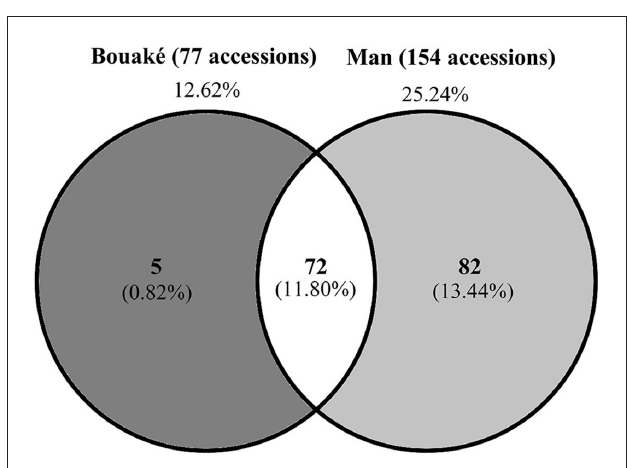
FIGURE3 Proportion of Cassava mosaic disease (CMD) symptomless accessions observed in 610 Côte d’Ivoire cassava germplasm collection maintained at Bouaké and Man site.